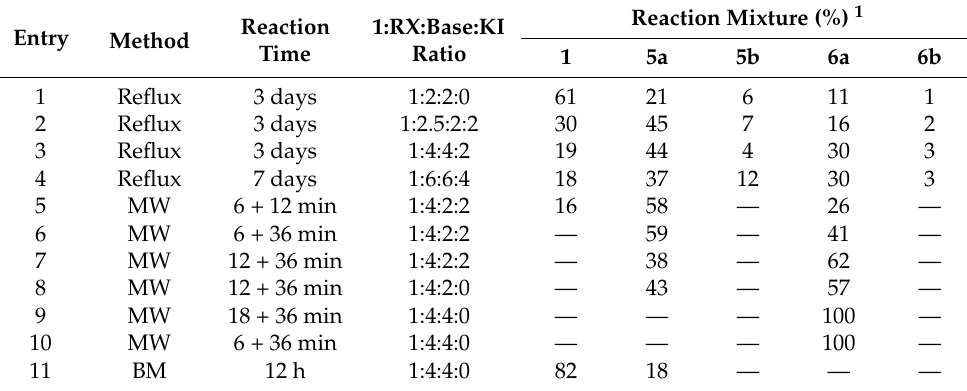
Scheme 2. Synthesis of ethylphthalimide derivatives 5 and 6 . Table 2. Conditions and product percentages of reaction of 1 with Br(CH 2 ) 2 Pht.